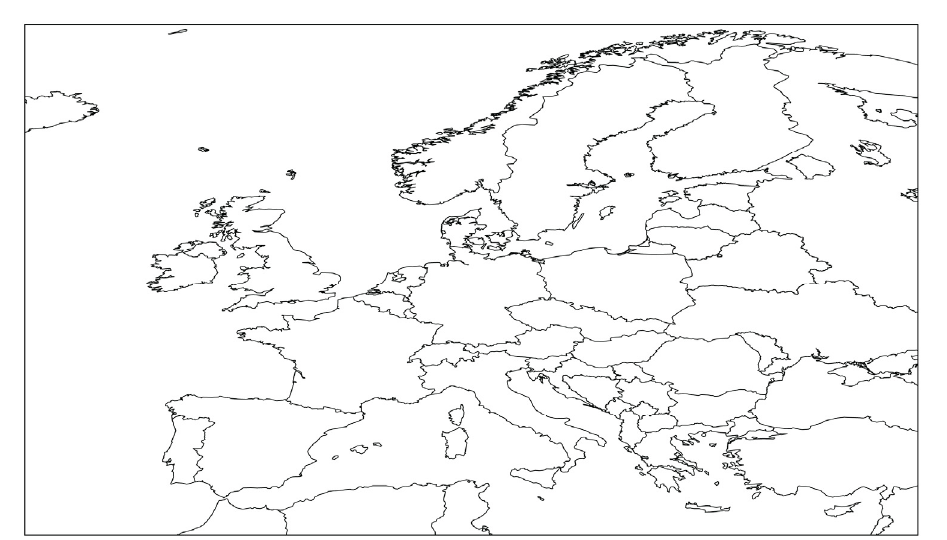
Figure 1. Modeling